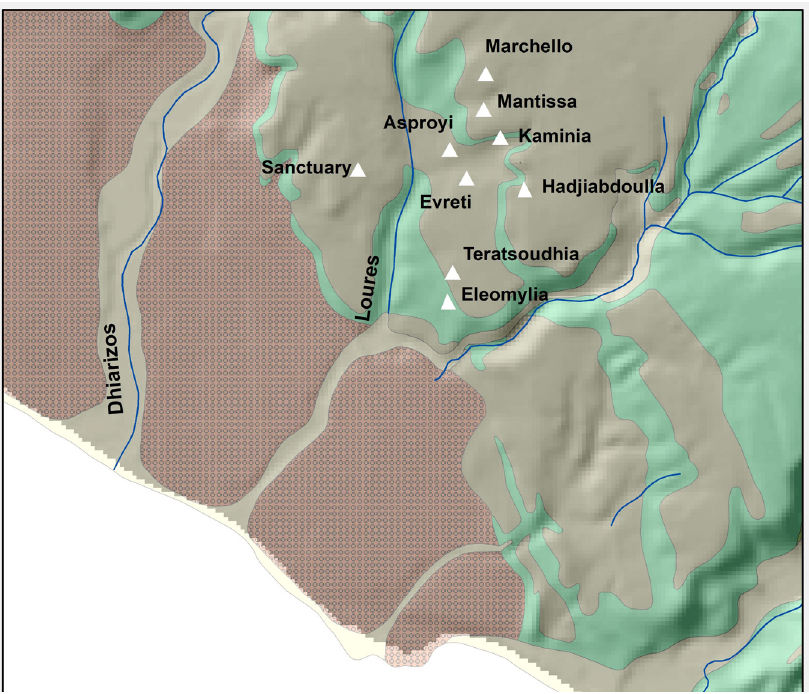
Figure 13. Geological map of the wider Palepaphos area with location of LC burial clusters. Drafted by A. Agapiou (PULP@).